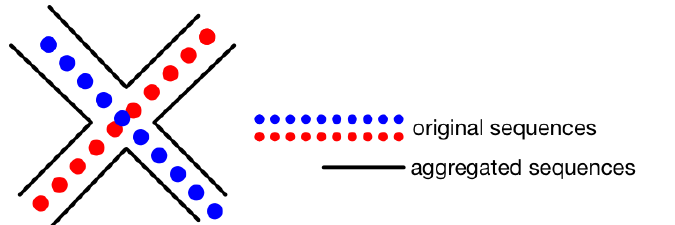
Figure 8. An illustration for sequence aggregating. After aggregating the original two sequences, 4 new sequences are